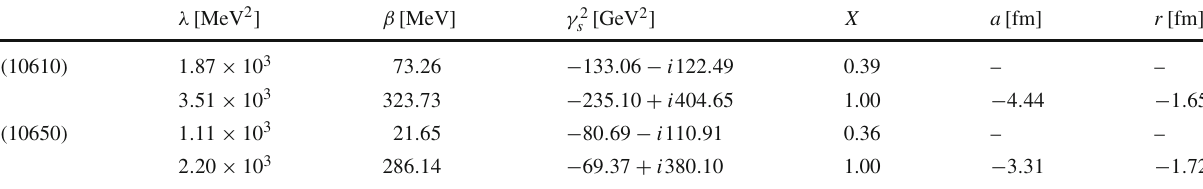
Table 2 Several physical quantities are calculated for resonances Z b ( 10610 ) and Z b ( 10650 ) , based on the fitted parameters of b 0 ,α, Y Z and given value of M CDD in Table 1. From left to right, the values of λ ,